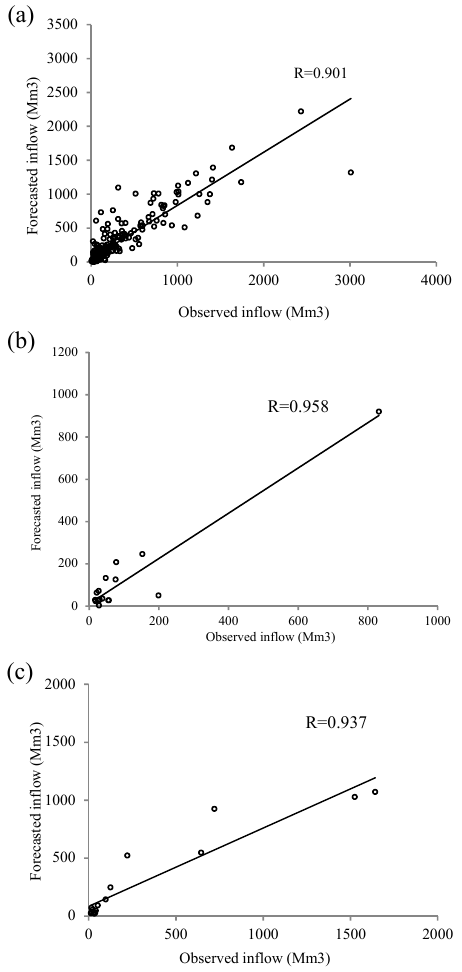
Figure 3. Inflow (a) auto-correlation, (b) partial autocorrelation functions, and (c) inflow-rainfall cross-correlation function for Ubonratana system. Figure 4. Comparing the 1-month ahead observed and forecast in- flow during (a) training, (b) validation, and (c)